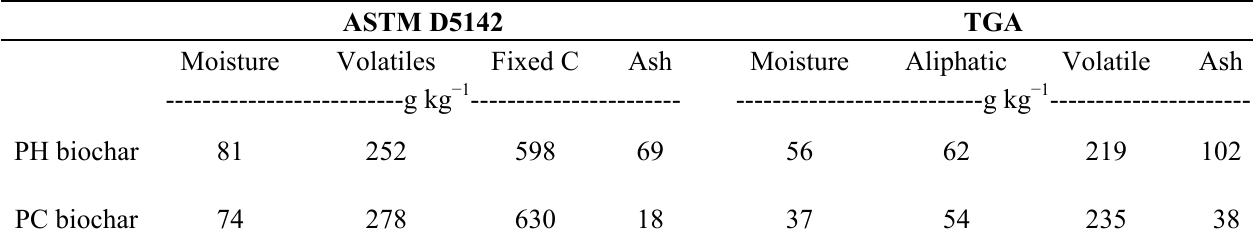
Table 2. Proximate analysis (ASTM D5142) and estimated parameters from isothermal decomposition (TGA) of fresh